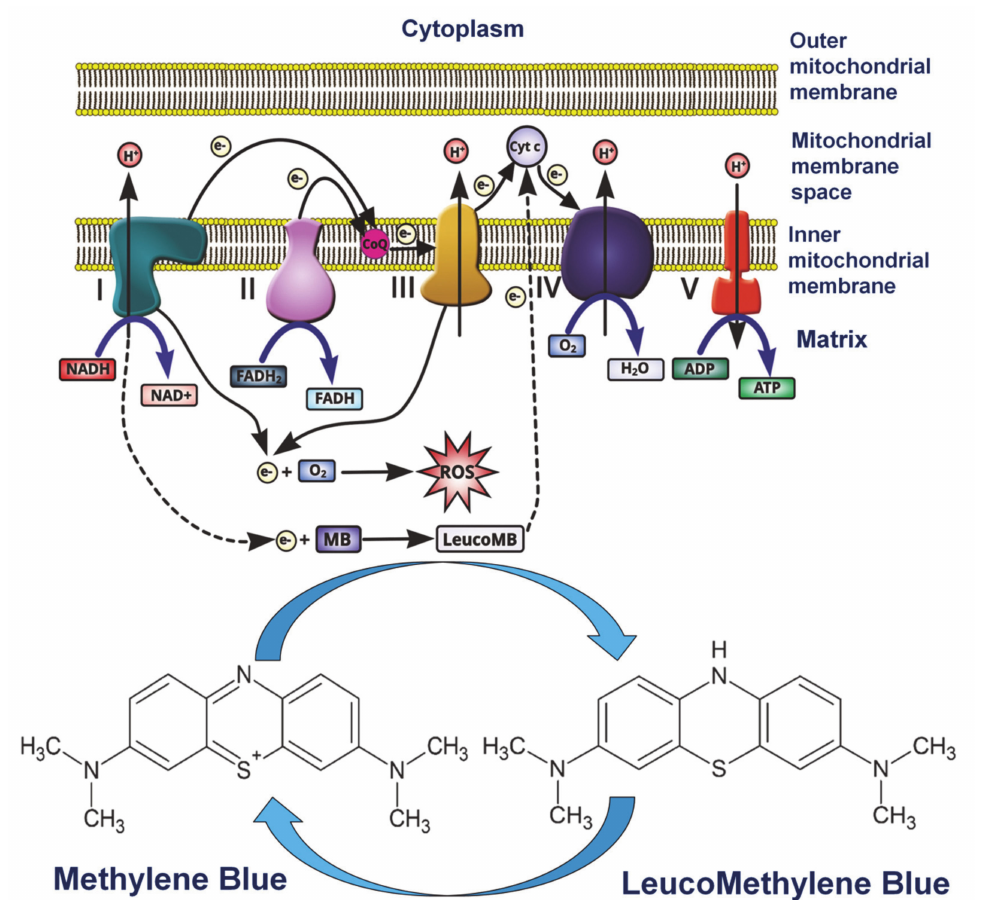
Figure 2. Diagram of MB as an alternative mitochondrial electron transporter. More details can be found in text. Reproduced with permission from